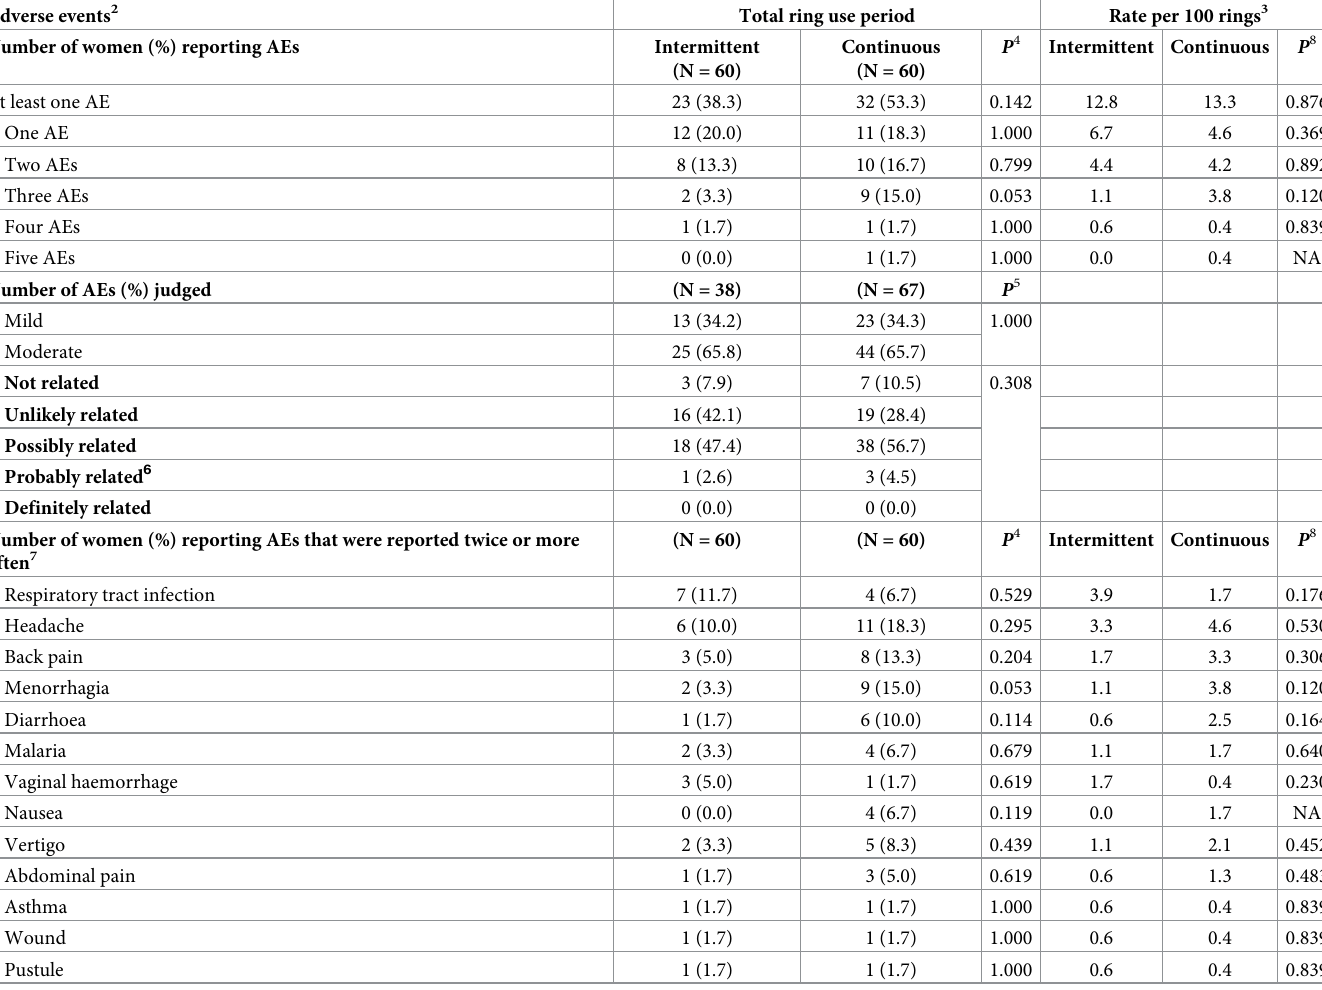
Table 4. Spontaneously reported 1 adverse events: comparison by group for the total ring use period and per 100 used